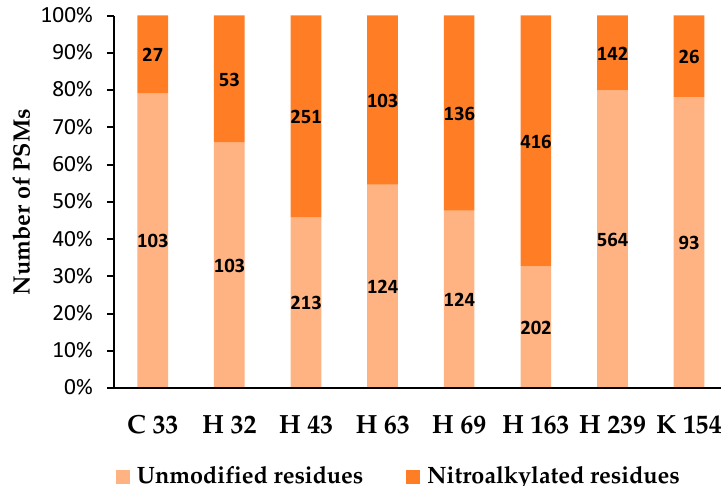
Figure 6. Detection of nitroalkylated residues in cytosolic recombinant APX by mass spectrometry (LC-MS/MS). The number on each column represents the number of PSMs of the unmodified residue related to the nitroalkylated residue. PSM: peptide-spectrum match.